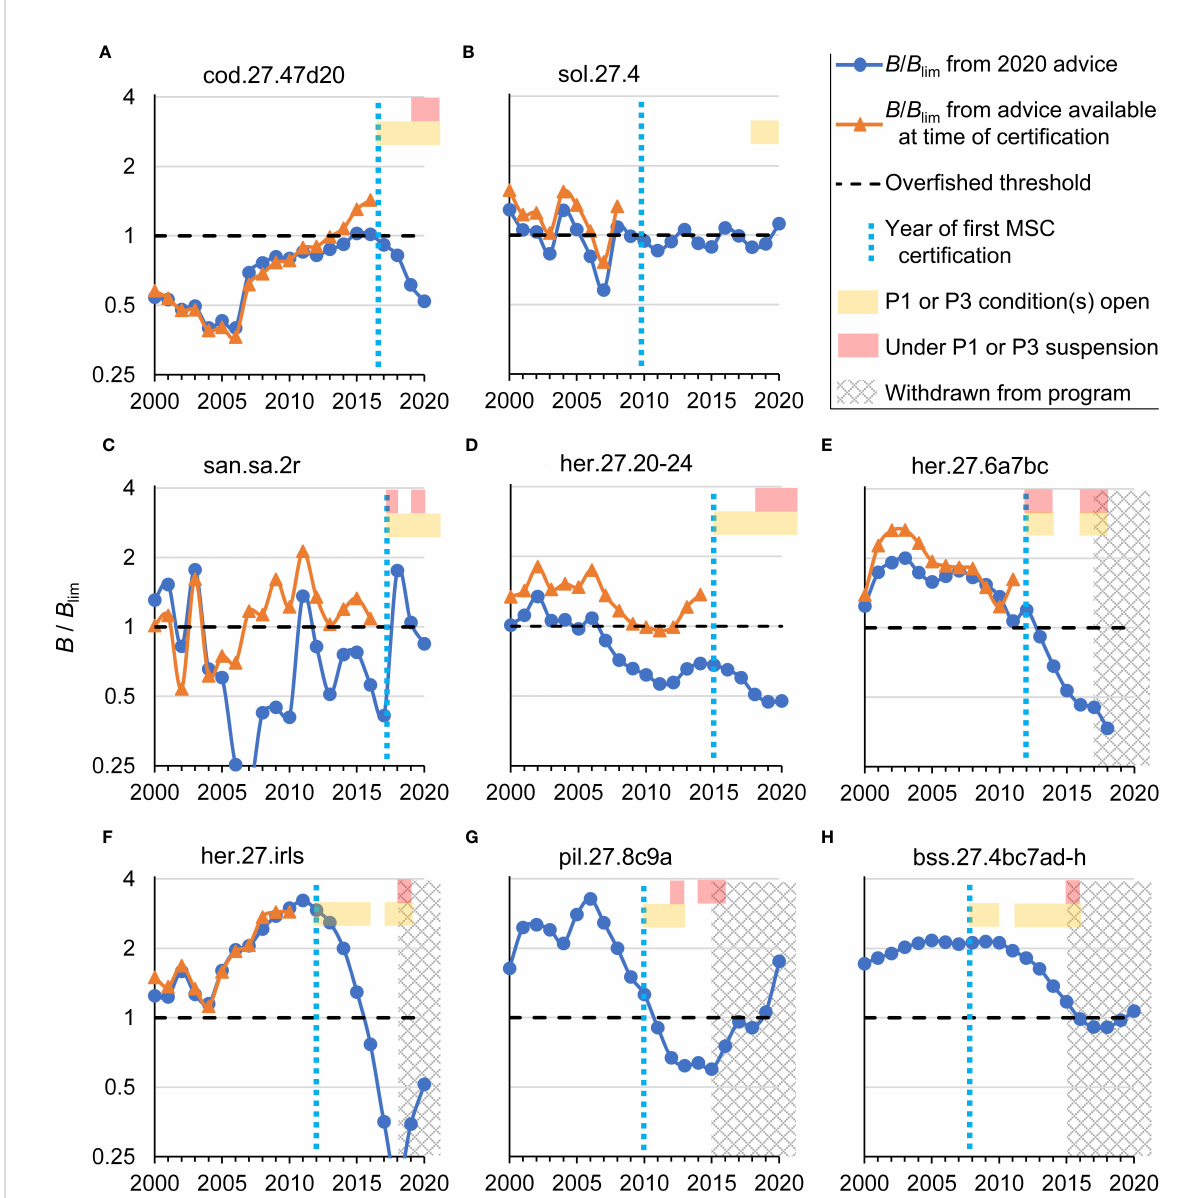
FIGURE 5 Stock status and certi fi cation histories of eight MSC stocks for which B / B lim estimates from 2020 ICES Advice Reports were below the ‘ over fi shed ’ threshold in 2017 or 2018. B / B lim is shown on log scale with truncated axis at lowest value. Blue circles show estimates from this recent assessment. Orange triangles show corresponding estimates from the earlier ICES Advice available at the time of certi fi cation, with the exception of two stocks for which biomass reference point estimates were not available prior to certi fi cation. Year of fi rst certi fi cation and, if applicable, years with open conditions or years under suspension related to MSC Principles 1 or 3 are indicated. For four stocks, hatching indicates the year in which the last remaining linked fi shery withdrew from the program. Time series are shown to year 2020 but only values to year 2018 were included in analyses. ICES stock codes are indicated, corresponding to full names (and RAMLDB stockid codes): (A) Cod – North Sea, eastern English Channel, and Skagerrak (CODIIIaW-IV-VIId); (B) Sole – North Sea (SOLENS); (C) Sandeel Area 2r – Skagerrak, central and southern North Sea (SEELNSSA2); (D) Herring spring spawners – Skagerrak, Kattegat, and western Baltic (HERR2224IIIa); (E) Herring – West of Scotland and West of Ireland (HERRVIaVIIbc), which consists of two sub-stocks that were assessed separately prior to 2016, with pre- certi fi cation estimates speci fi c to the sub-stock in area VIa (North); (F) Herring – Irish Sea, Celtic Sea, and southwest of Ireland (HERRSIRS); (G) Sardine – Cantabrian Sea and Atlantic Iberian waters (SARDPVIIIc-IXa); and (H) Seabass – central and southern North Sea, Irish Sea, English Channel, Bristol Channel, and Celtic Sea